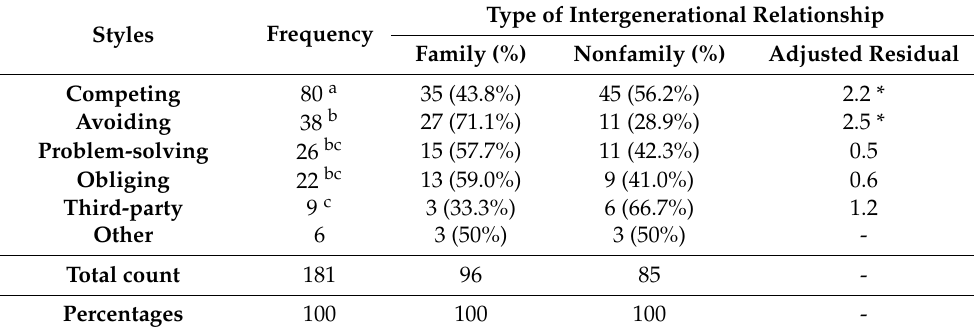
Table 5. Frequencies of the identified conflict management styles used by young people with grandparents and nonfamily older adults.